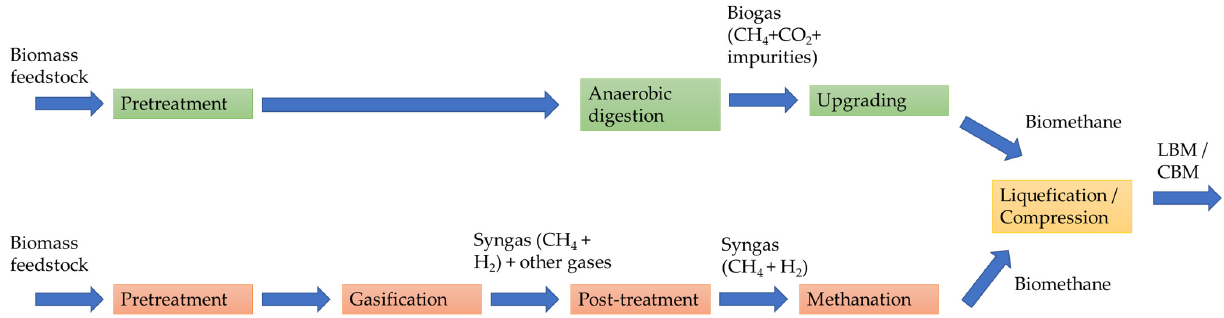
Figure 1. Conversion routes to produce liquefied/compressed biomethane.